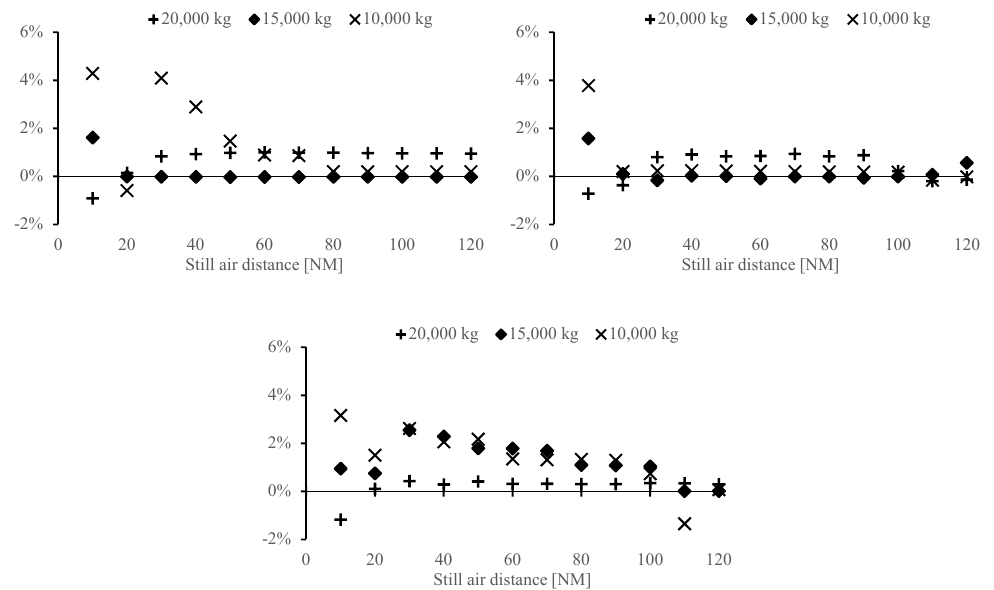
Figure 13. Observed errors in the in-flight uncertainty calibration for the three sample payloads and weather scenarios A (top, left), B (top, right), and C (bottom).